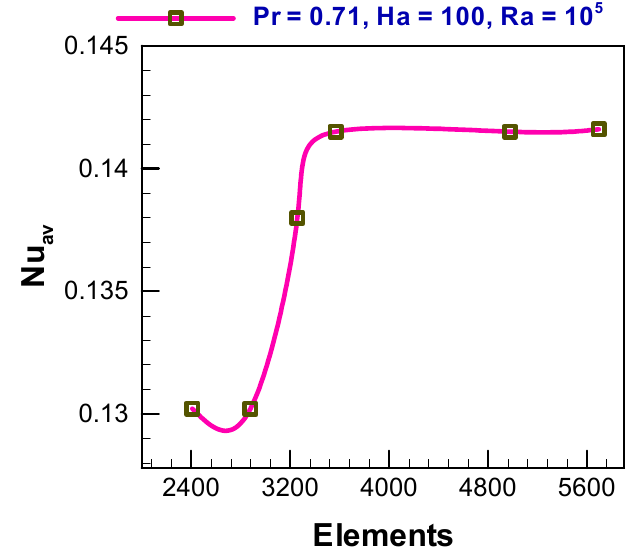
Figure 4. Grid sensitivity tests for Pr = 0.71, Ha = 100 and Ra = 10 5 . Table 1. Grid sensitivity tests at Pr = 0.71, Ha = 100 and Ra = 10 5 .